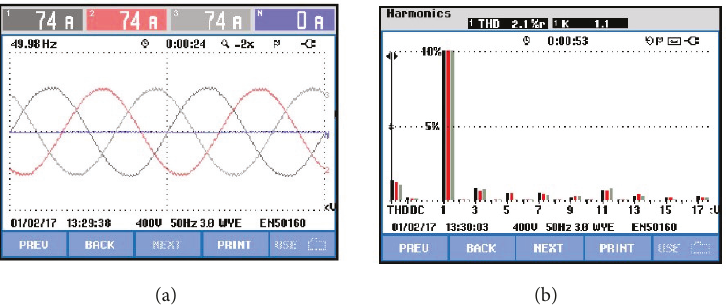
Figure 20: The experimental waveforms and THD of grid currents using the proposed method ( 𝑘